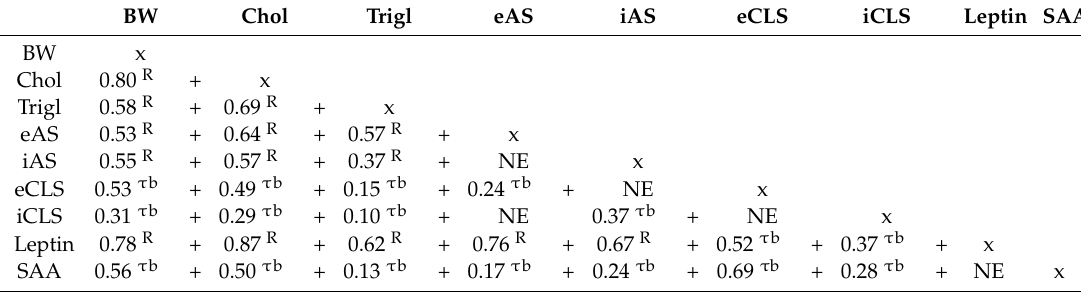
Table 2. Correlation coefficients among mid-adult